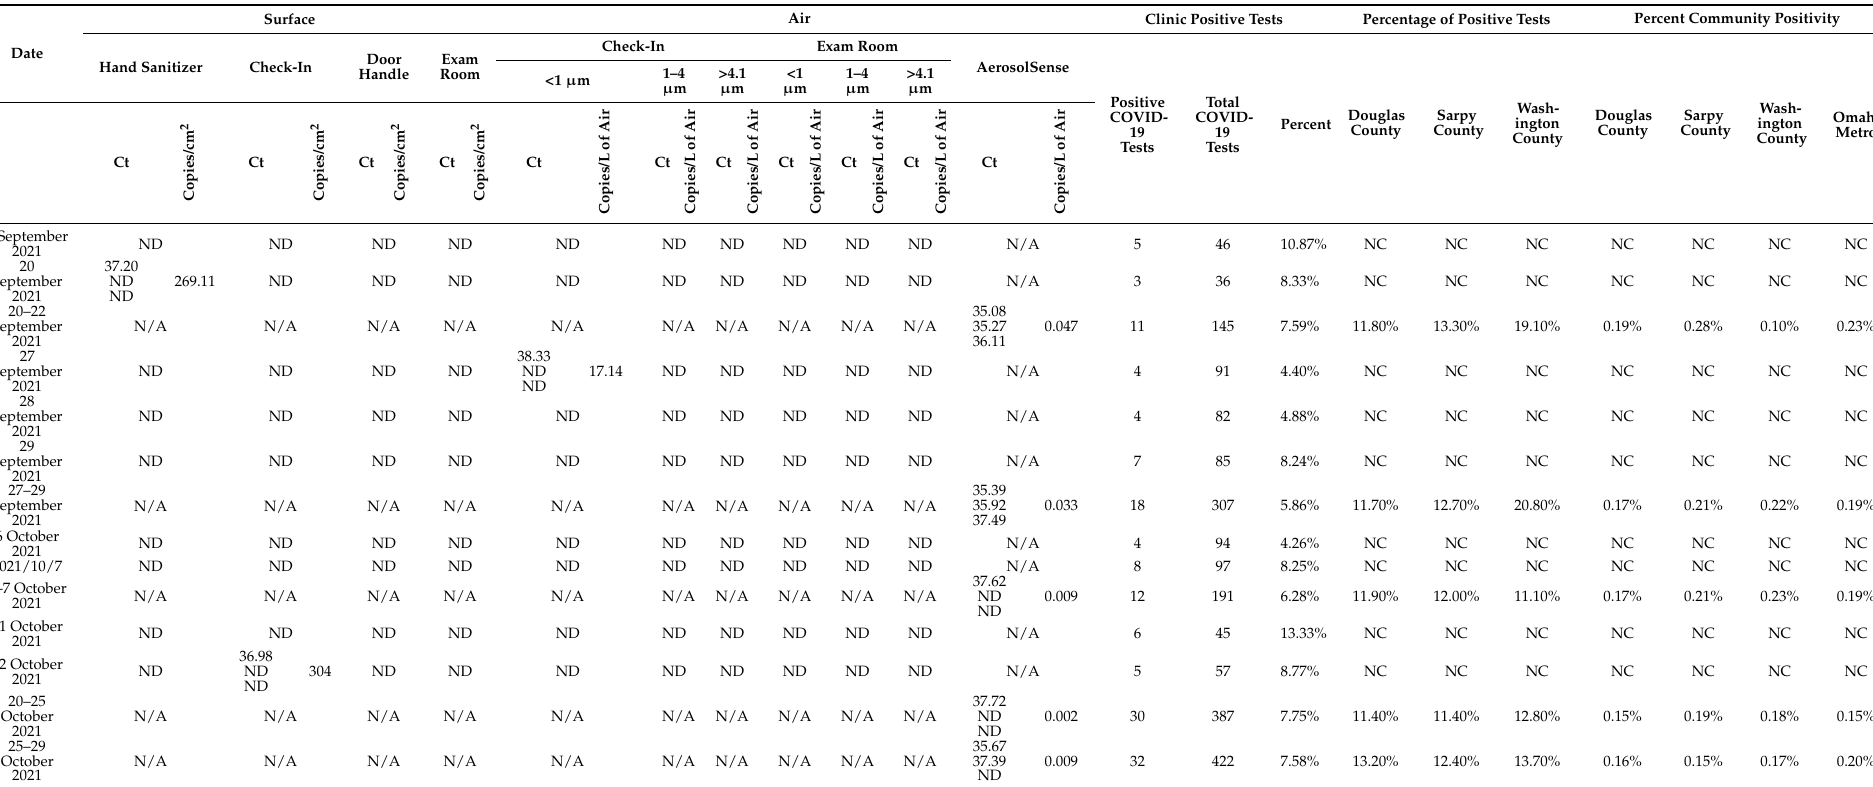
Table 2. Summary of RT-qPCR Ct values collected from the Nebraska Medicine campus clinic, test positivity rates from the clinic and the surrounding community, and community positivity rates per 100,000 individuals. ND indicates non-detected samples; NC indicates that the value was not calculated; N/A indicates the valuable in not